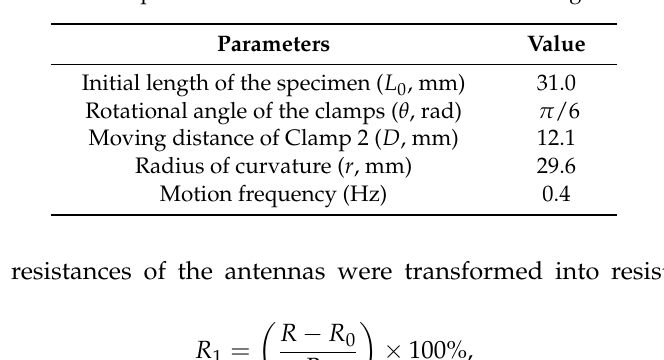
Table 1. Experimental conditions for rotational bending tests.